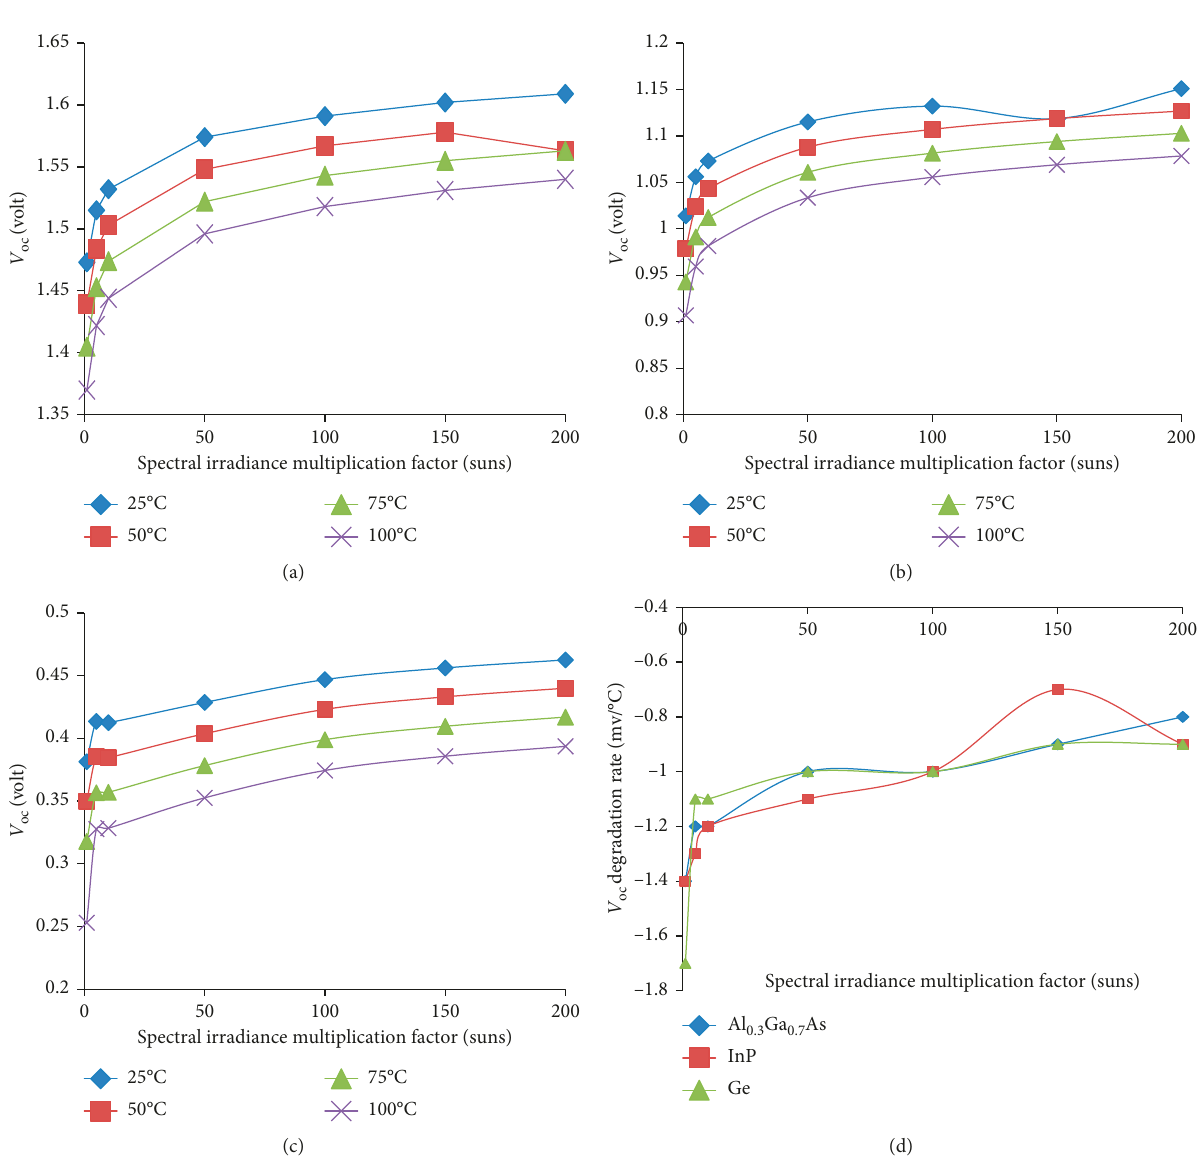
oc ) of (a) the first subcell Al 0.3 Ga 0.7 As, (b) the second